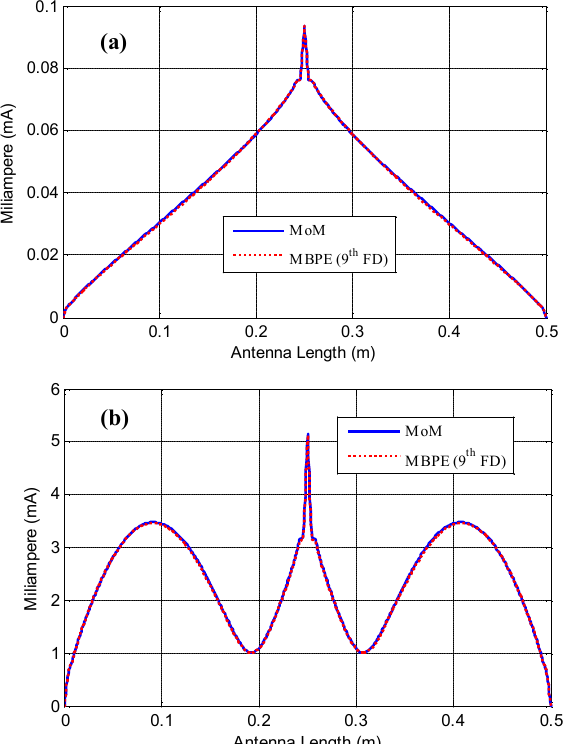
Figure 2: Current distribution on the thin wire antenna at a) f = 0.02 f 0 and b) f = 2.4 f 0 .